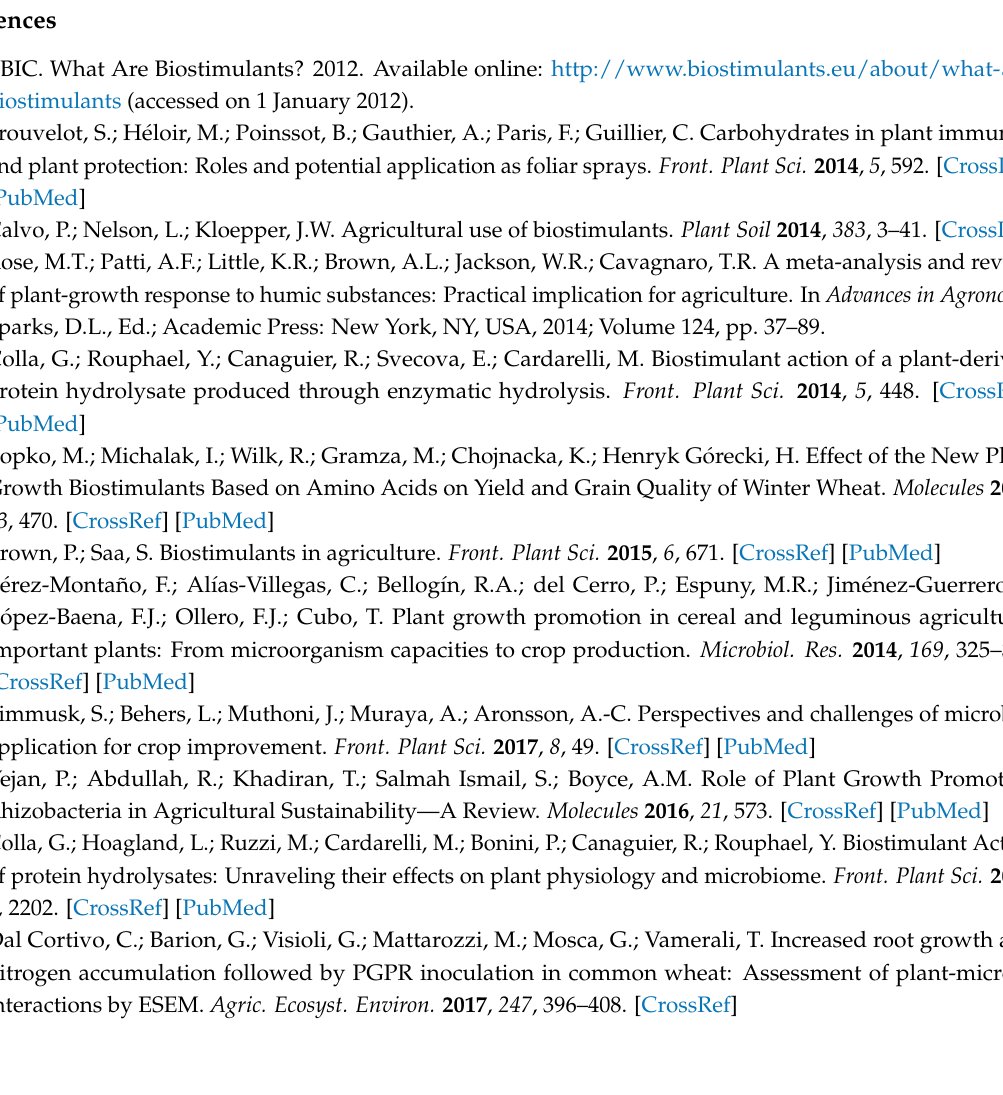
Supplementary Materials: The following are available online. Figure S1: Overview of aggregate samples from Chivasso at family level, taxa >0.6%; Figure S2 Overview of aggregate samples from Carignano at family level, taxa >0.6% Figure S3: Overview of aggregate samples from Carignano at genus level, taxa >0.6%; Figure S4: Overview of aggregate samples from Chivasso at genus level, taxa >0.6% Table S1: Data filtering report of